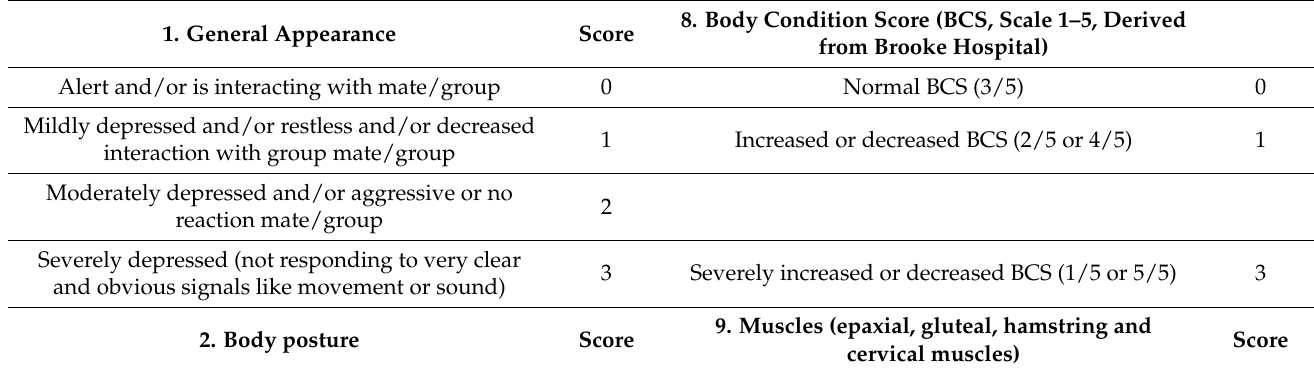
Table 2. Horse Chronic Pain CPS (Composite Pain